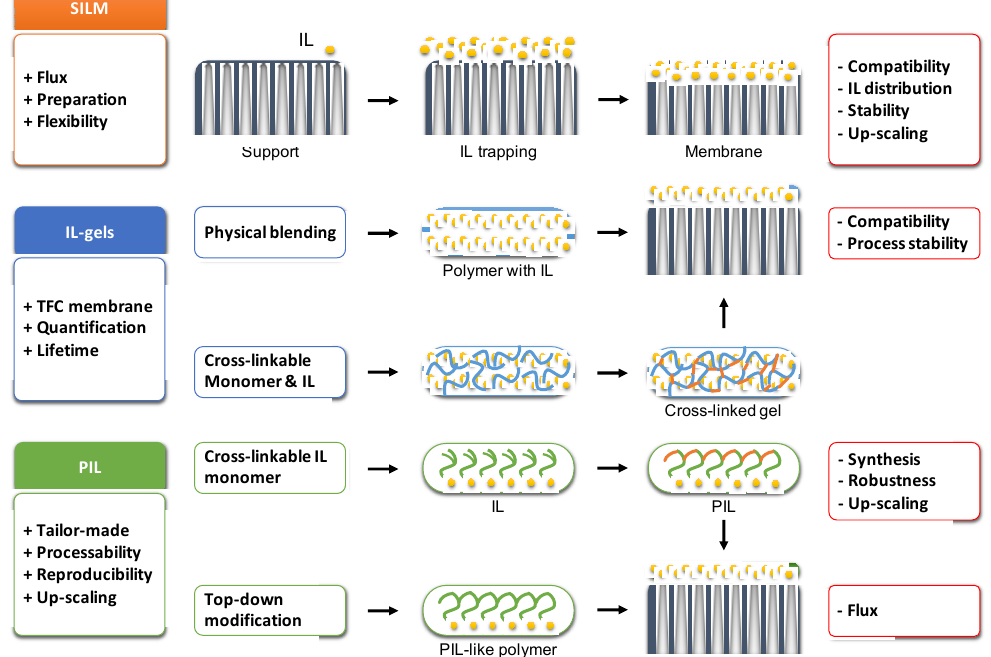
Figure 2. Schematic summary of the membrane characteristics and preparation techniques employing ionic liquid (IL)-based materials in membrane-based gas separation.